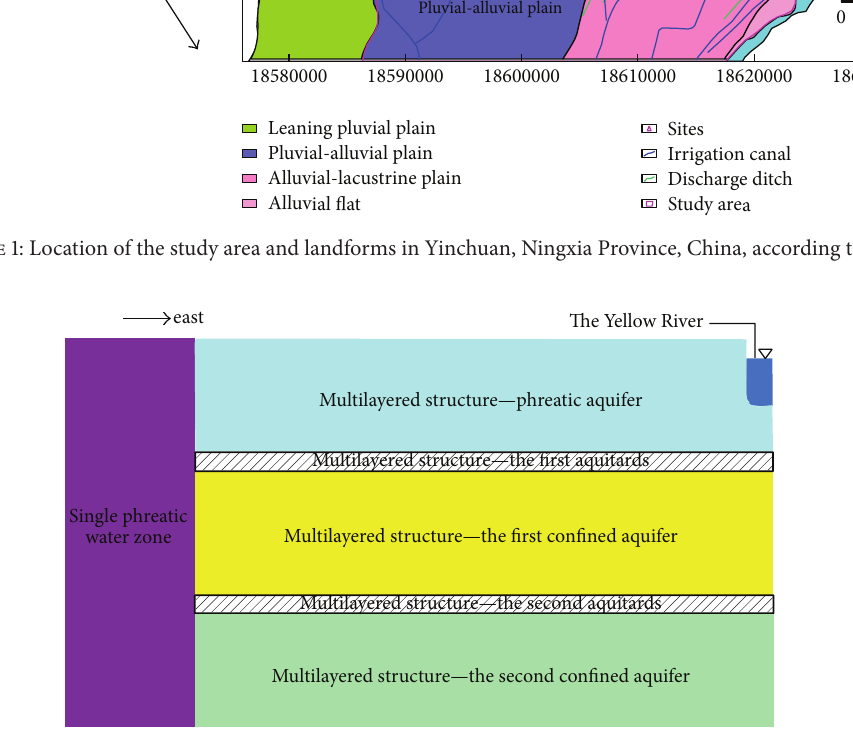
Figure 2: The conceptual scheme of hydrogeological cross section from A to A 󸀠